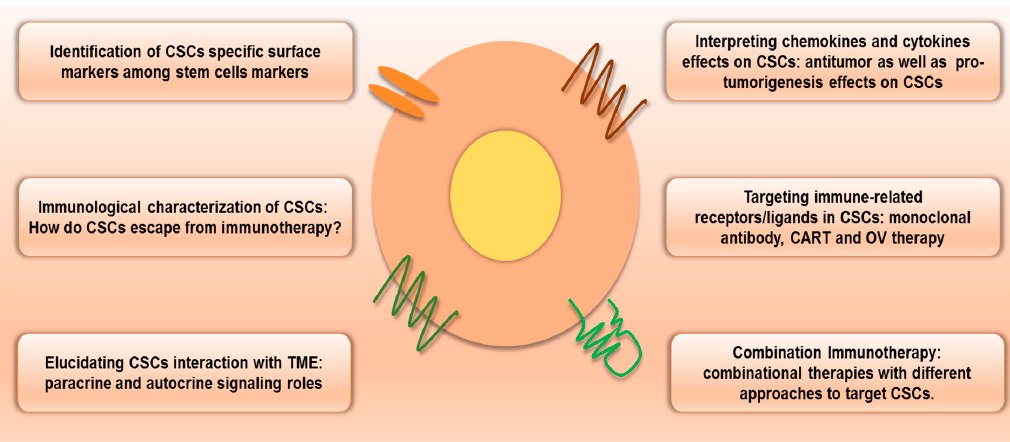
Figure 2. Prospective immunotherapeutic approaches to target CSCs. In order to target CSCs by immunotherapy, the identification CSCs specific surface markers and the immunological characterization of immune escaping with a complete elucidation of interaction with the TME are required. Chemokines’ and cytokines’ roles on CSCs are also related to immunotherapy. Immune receptors/ligands-based targeting by monoclonal antibody, CART and OV therapy. Owing to increase therapeutic efficacy, combination immunotherapy that consists of different approaches to target CSCs would be an ideal one (Abbreviations: CART, chimeric antigen receptor T-cells; CSCs, cancer stem cells; TME, tumor microenvironment, OV, oncolytic viruses).